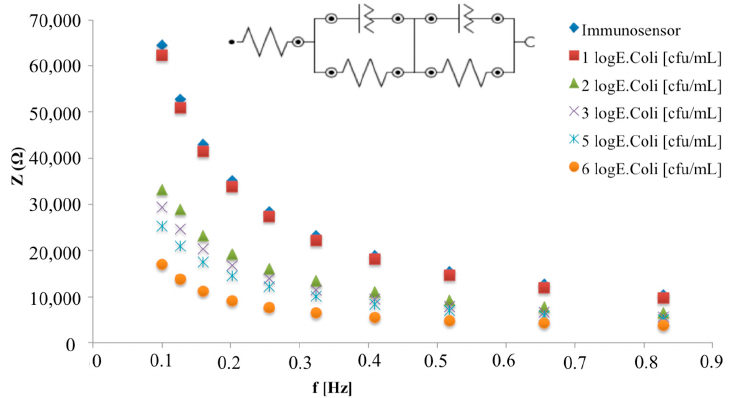
Figure 6. Bode plots in non-faradaic impedance measurements of the immunosensor before and after the interaction with different E. coli concentrations in the frequency range 0.1–1 Hz. The inset shows the equivalent circuit used for impedimetric data fitting.